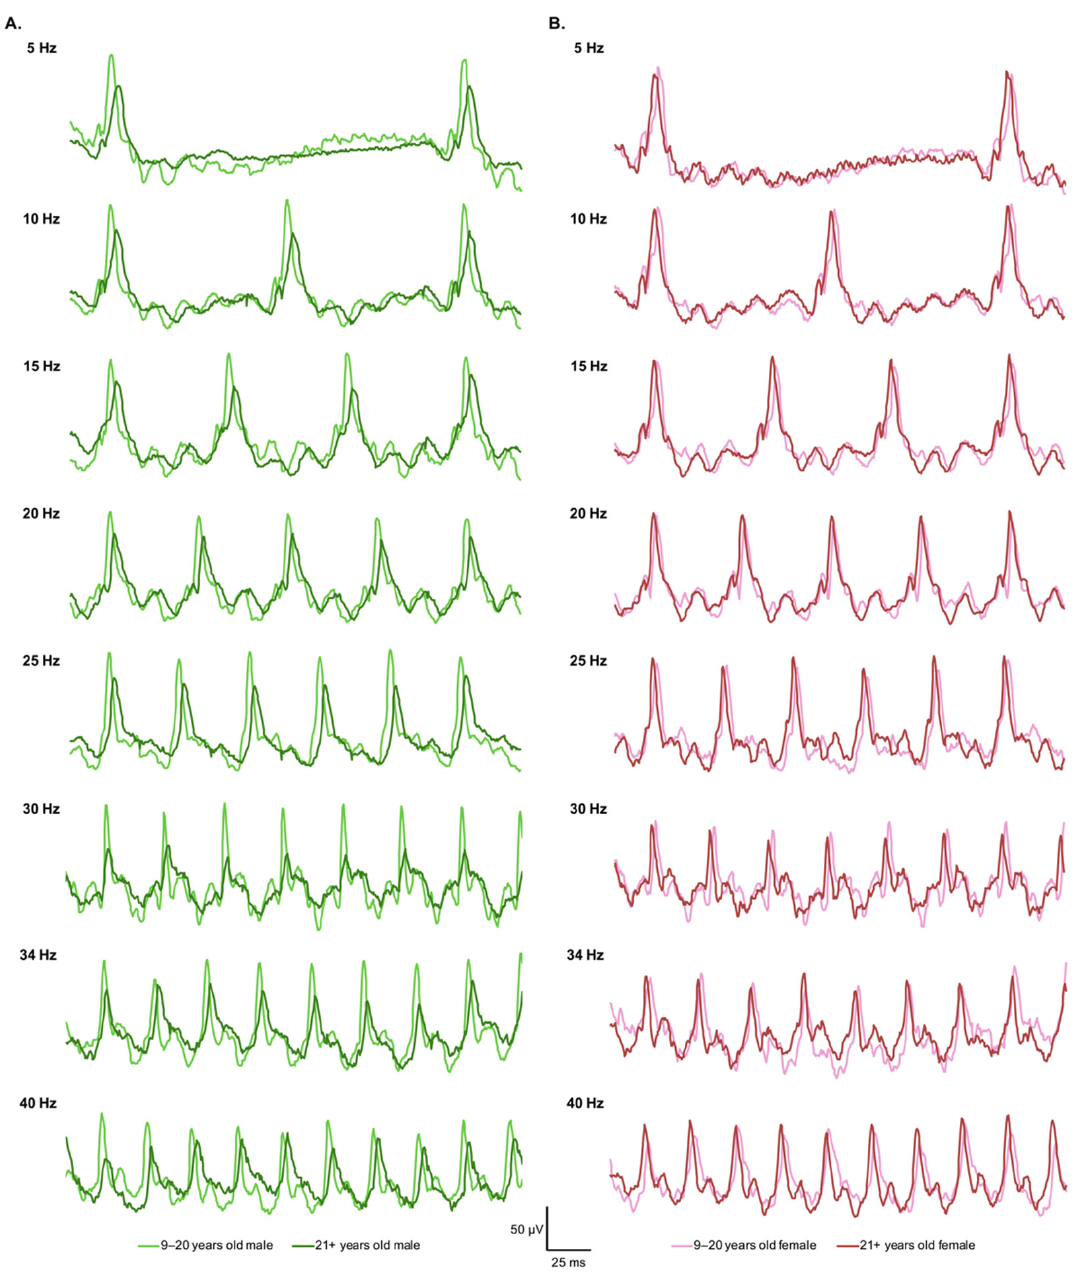
Figure 4. ( A ). Representative flicker ERG traces of a young male subject (light green) and an old male subject (dark green). Note the decrease in the amplitude of the response with aging. ( B ). Representative flicker ERG traces of a young female (pink) and an old female (red) subjects.